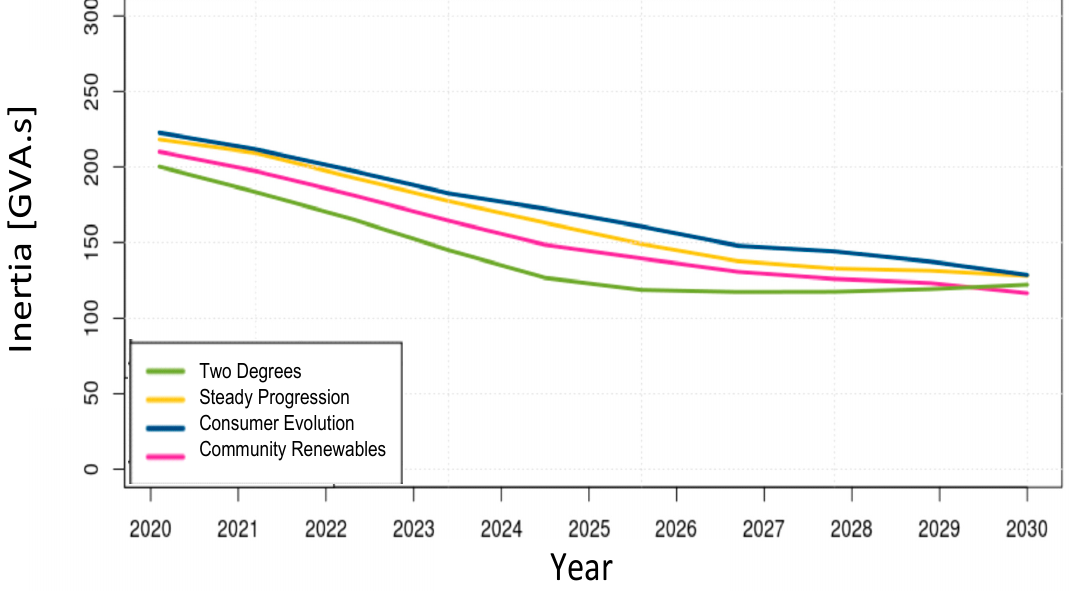
Figure 2. GB inertia trend based on FES 2018 data [1].